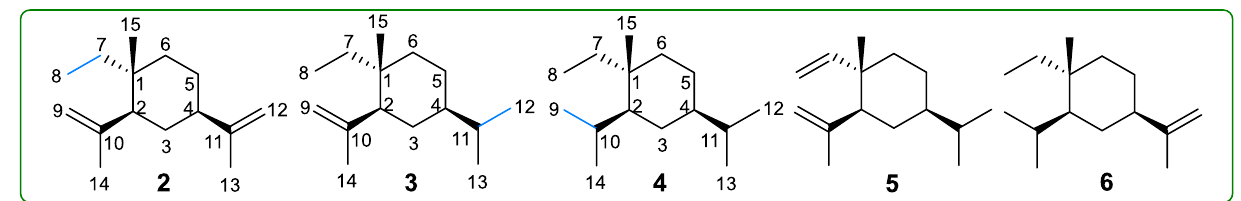
Figure 3. Chemical structures of β -elemene reduction derivatives 2 – 6 .